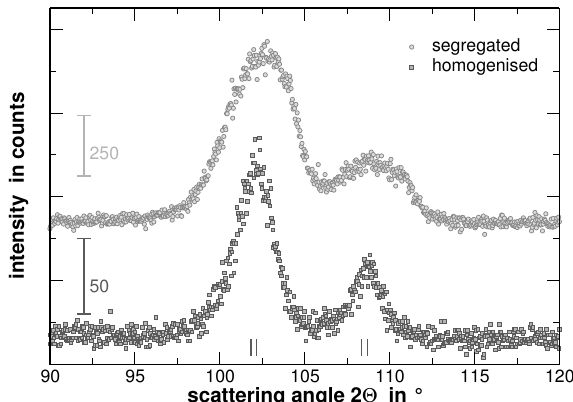
Figure 3. High-angle range of two XRD patterns of AuCuNiPt in the homogenized as well as segregated state. The whole diffraction patterns are shown in Figures 1 and 4.